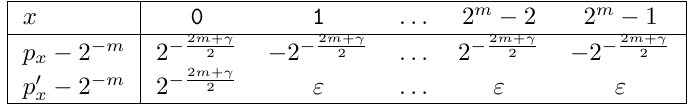
Table 4: Two probability distributions P and P